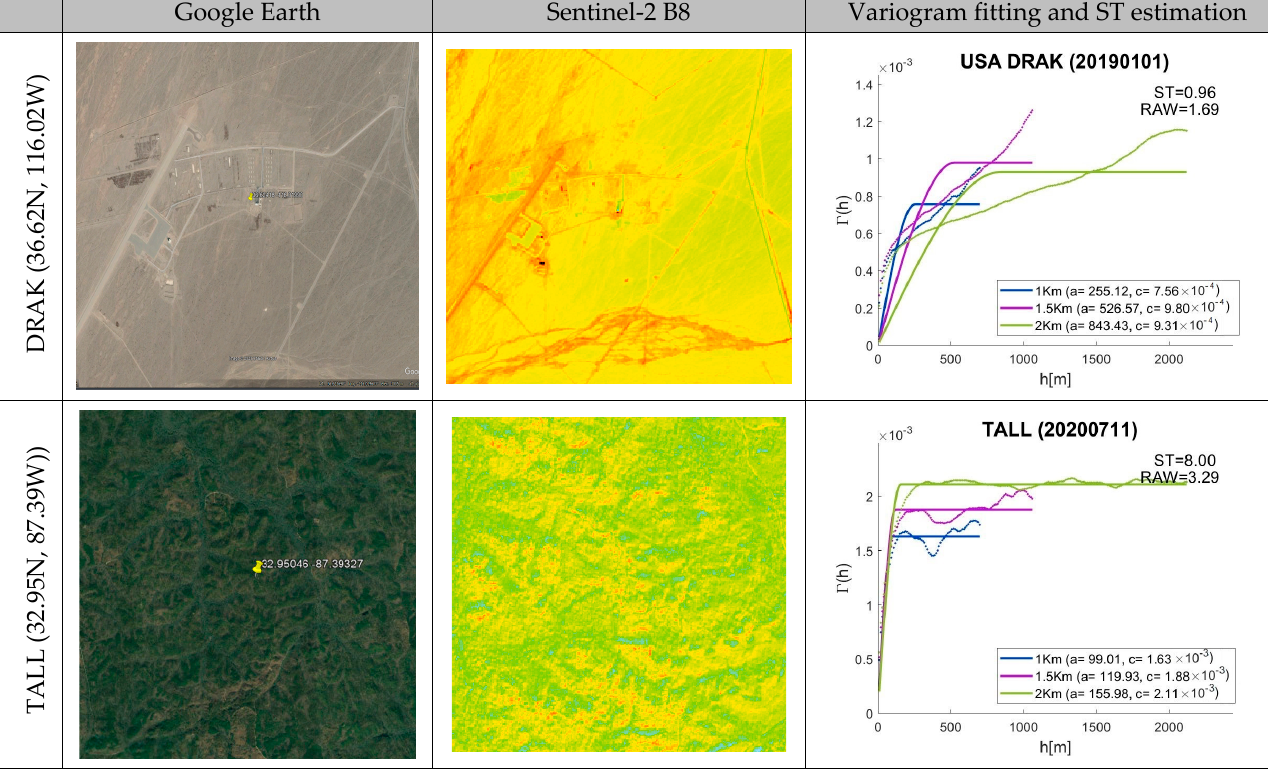
Figure 2. Example of variogram fitting and ST estimation over two different sites, Desert Rock (DRAK) and Talladega National Forest (TALL).